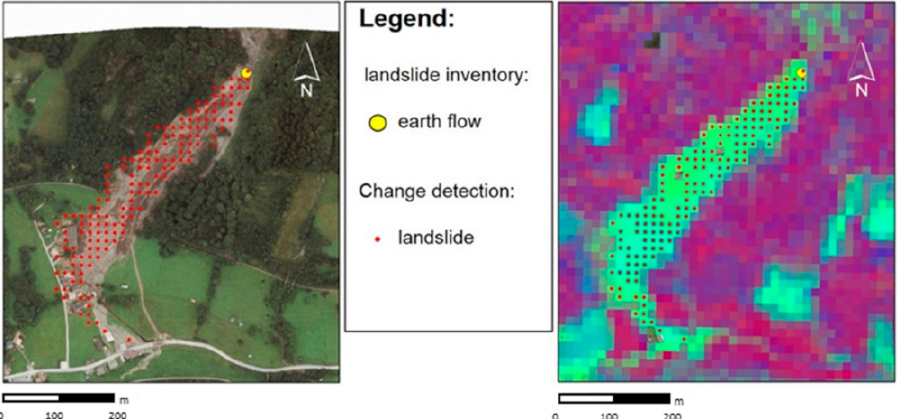
Figure 19. Landslide classification results of the Danöfen earth flow (as seen in Figure 4a) (Aerial- photos©